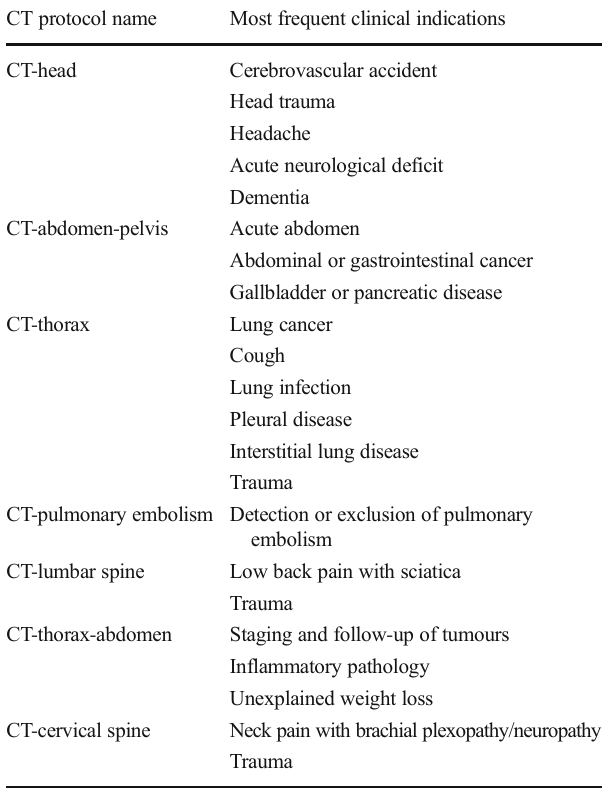
Anatomical B CT regions ^ and associated most frequent clinical